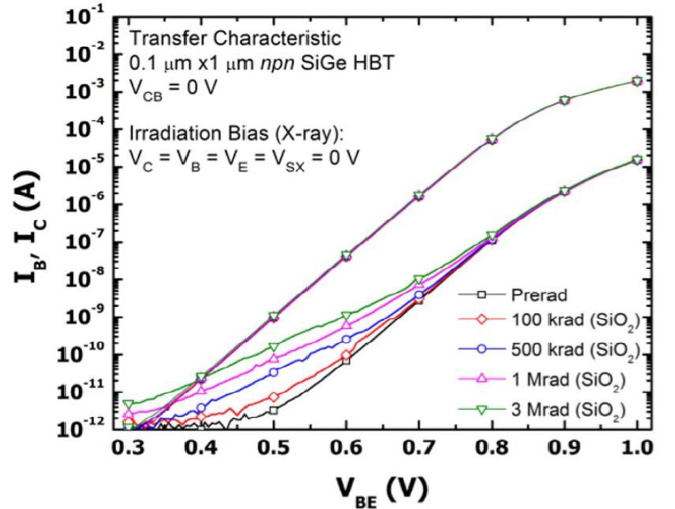
Figure 3. Transfer characteristics of a SiGe HBT following various total radiation doses. Upper family of curves shows collector currents I C and lower family shows base currents I B . Used with permission from